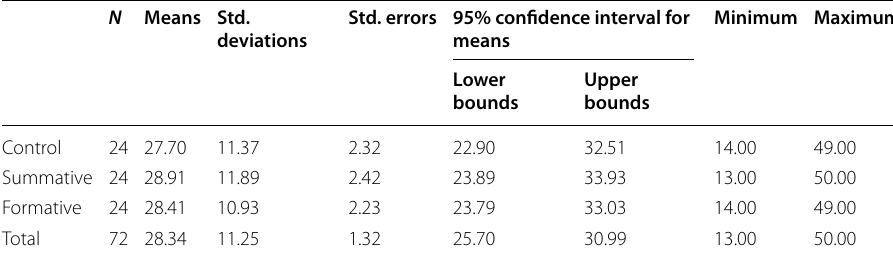
Table 1 Descriptive statistics of all groups on the test anxiety pre-tests N Means Std. Std. errors 95% confidence interval for deviations